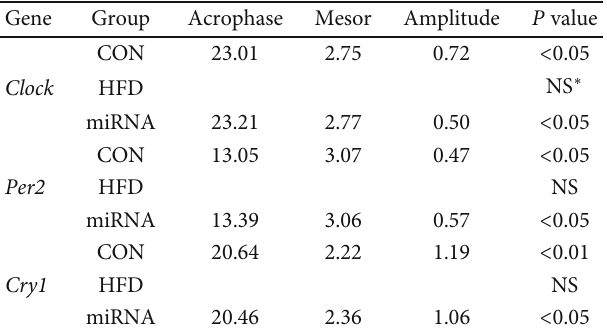
Table 2: Mesor, amplitude, and acrophase of mRNA levels of clock genes in the liver of mice.